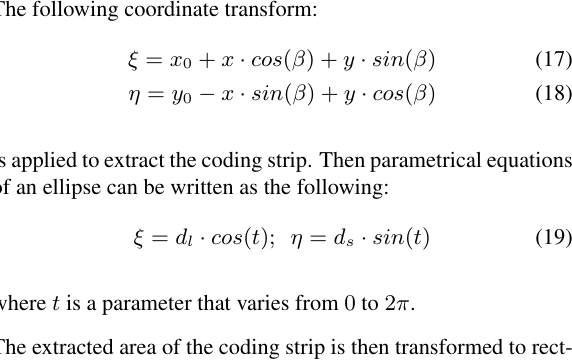
Figure 4. Example results of code